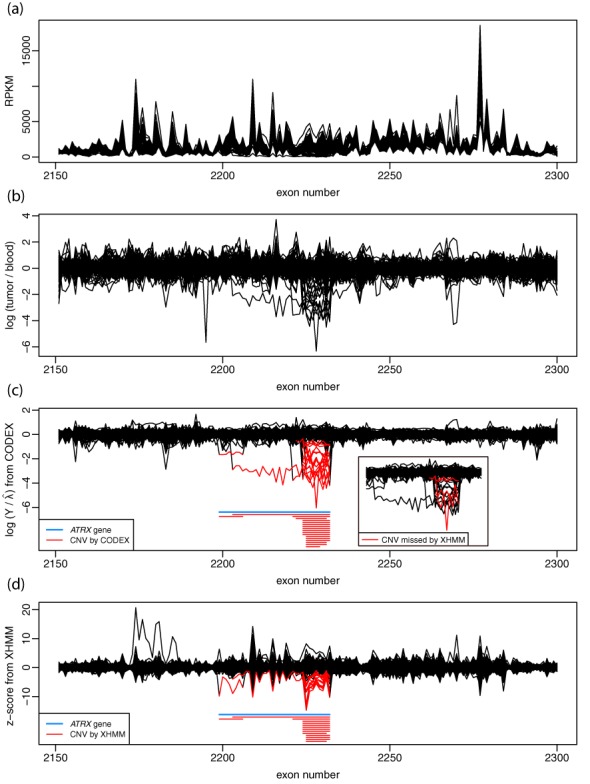
Detection of rare somatic deletions within ATRX by WES of 222 neuroblastoma-matched tumor/blood samples. Location of ATRX is shown as blue bars in c and d. (a) RPKM computed from the tumor samples. There is no clear visual indication of presence of somatic CNVs from these raw quantities. (b) Log2-ratio of tumor versus blood read depth. Initial analysis by the TARGET Project did careful inspection of these values and discovered 16 samples with focal deletions. (c) Log2-ratio of the original tumor read depth Y versus the estimated control coverage \documentclass[12pt]{minimal}
\usepackage{amsmath}
\usepackage{wasysym}
\usepackage{amsfonts}
\usepackage{amssymb}
\usepackage{amsbsy}
\usepackage{upgreek}
\usepackage{mathrsfs}
\setlength{\oddsidemargin}{-69pt}
\begin{document}
}{}$\widehat\lambda$\end{document} (model fitted on tumor data set only) by CODEX. Poisson likelihood-based segmentation algorithm by CODEX discovers 18 samples (red bars) with somatic deletions that exhibit a nested structure across samples. The 4 samples that are called by CODEX but not by XHMM are colored in red in the embedded window. (d) XHMM's direct output: z-scores normalized by PC analysis. The HMM calling algorithm by XHMM detects 14 samples (red bars) with somatic deletions.